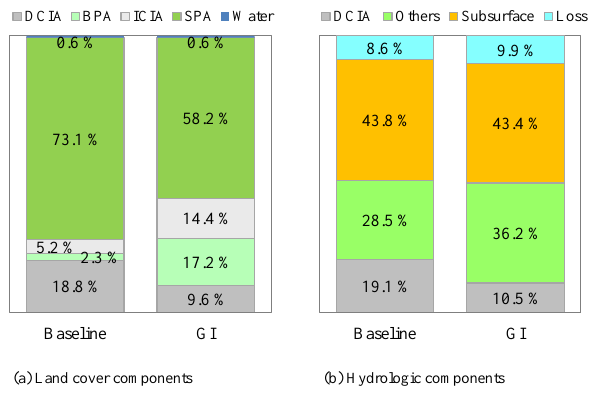
Figure 12. Relative percentages of (a) land cover and (b) hydro- logic components computed for the period 1 July 2009 to 31 August 2009. In (b) “others” represents surface runoff from areas other than DCIA, “subsurface flow” is the subsurface contribution, and “loss” is rainfall loss by evaporation or deep percolation.